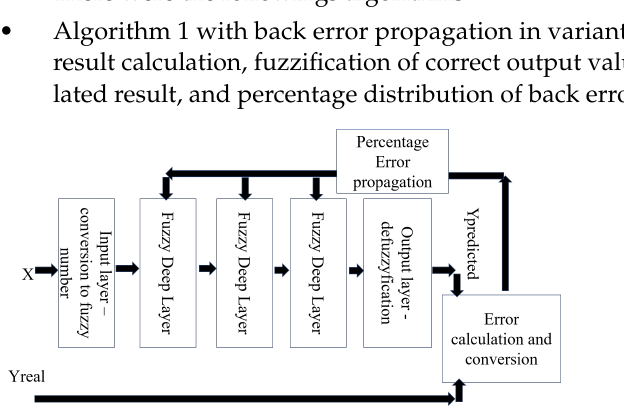
Figure 6. First learning